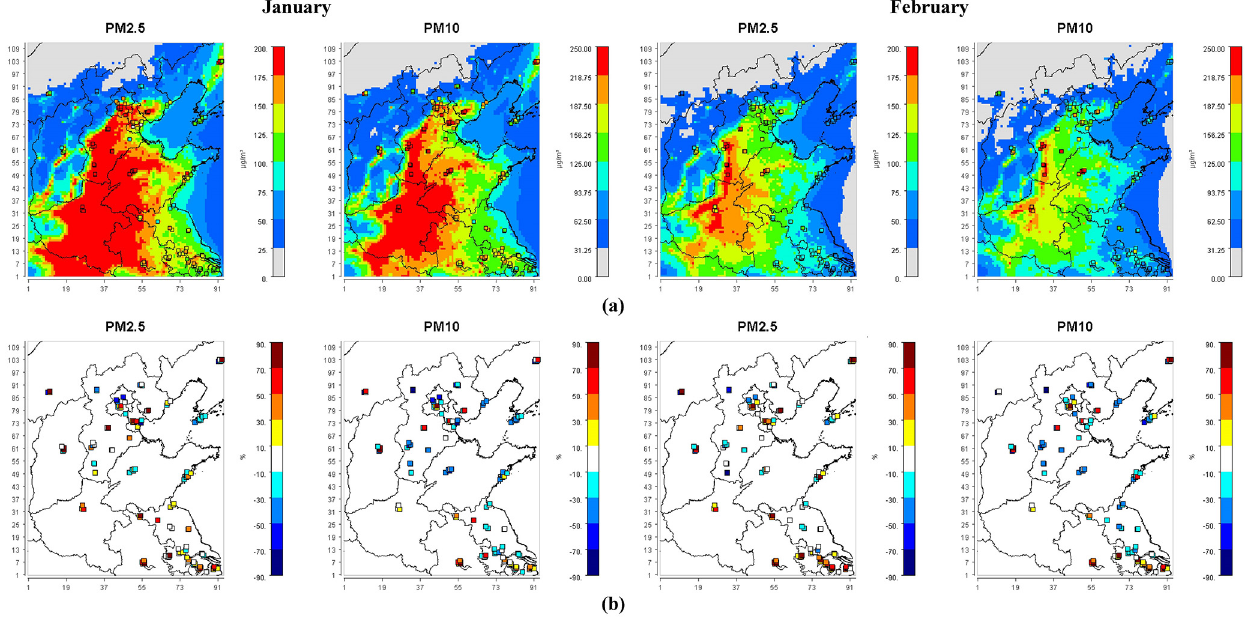
Fig. 5. (a) Overlay of the simulated and observed monthly-average concentrations of PM 2 . 5 and PM 10 of the reported 235 sites and (b) the corresponding spatial distributions of NMBs for PM 2 . 5 and PM 10 at the 12km horizontal grid resolution for January and February, 2013. Note the average for January is from 14 January to 31 January. Square signs indicate the